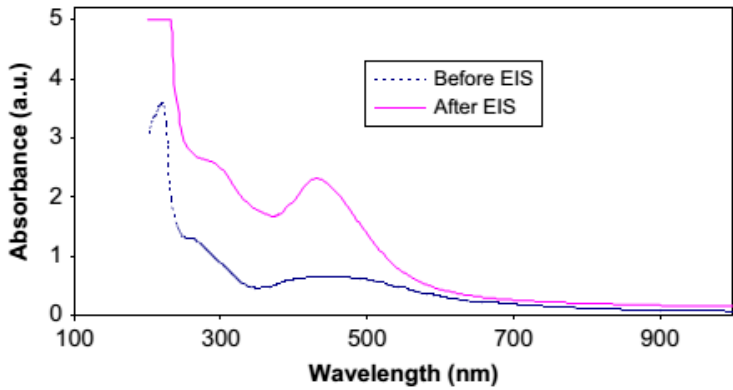
Figure 12. UV–vis spectra of chitosan–AgCF 3 SO 3 before (room temperature) and after (high temperature) electrochemical impedance spectroscopy (EIS)